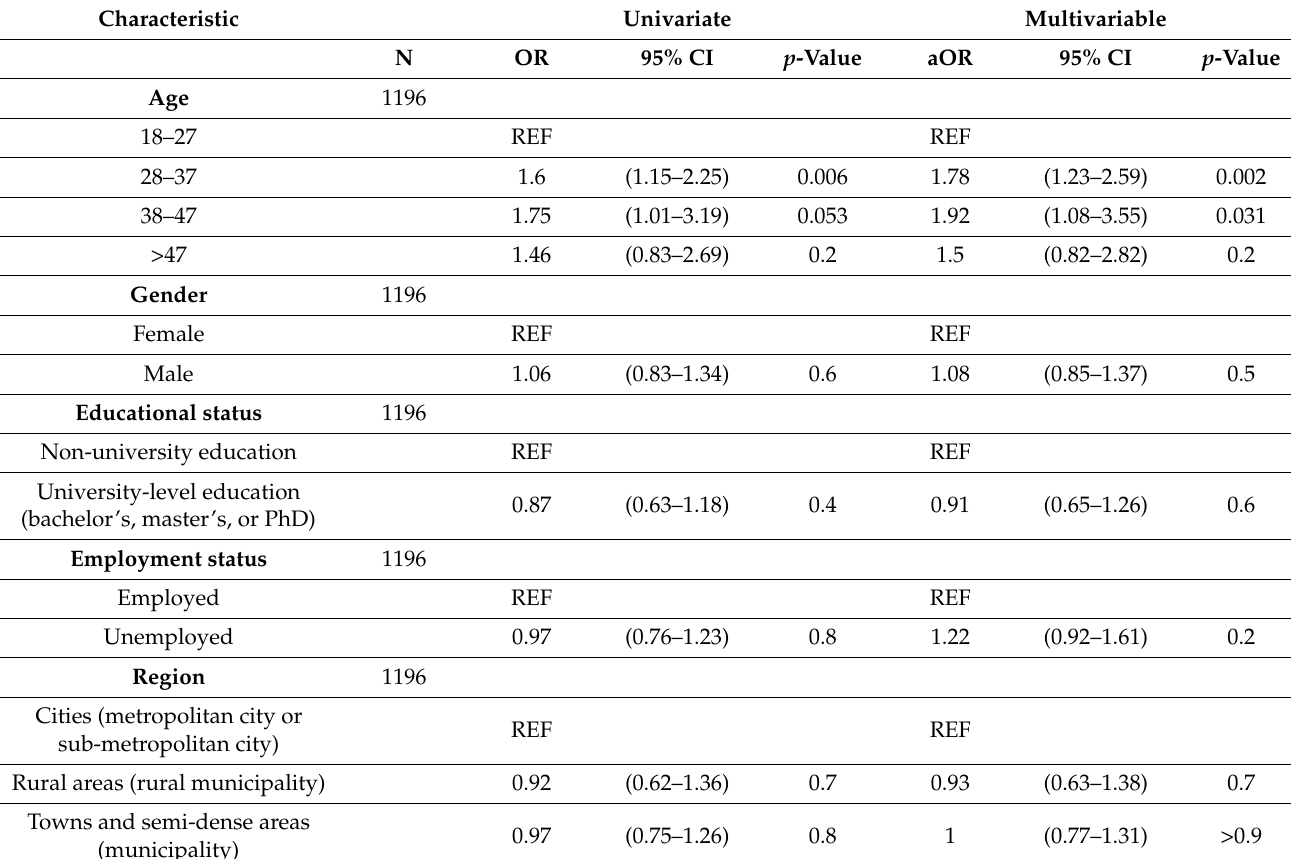
Table 2. Univariate and multivariate logistic regression model of perception on COVID-19 vaccine safety. Characteristic Univariate